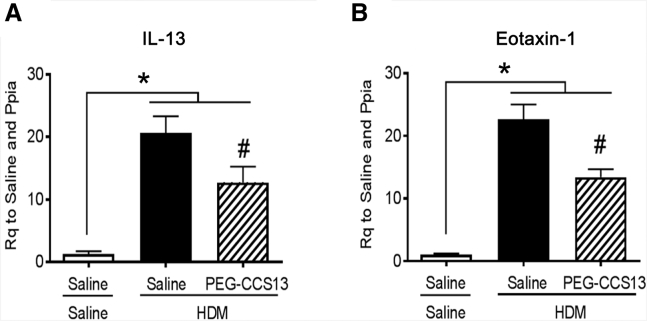
Treatment with PEG-CCS13 Attenuates Inflammatory Gene Expression in an Acute Model of Allergic Airway InflammationPulmonary gene expression analysis (Rq, relative quantification) by qPCR revealed significantly increased expression of the allergic immune mediators IL-13 (A) and Eotaxin-1 (CCL-11) (B) in lung tissue of HDM-sensitized mice; treatment of HDM-mice with PEG-CCS13 reduced expression of both mediators compared to control treatment with saline. Each bar represents the mean gene expression value ± SD. *p < 0.05, HDM + saline versus saline control mice; #p < 0.05, PEG-CCS13 versus saline and HDM + saline subgroups; n = 6–7 mice per group.